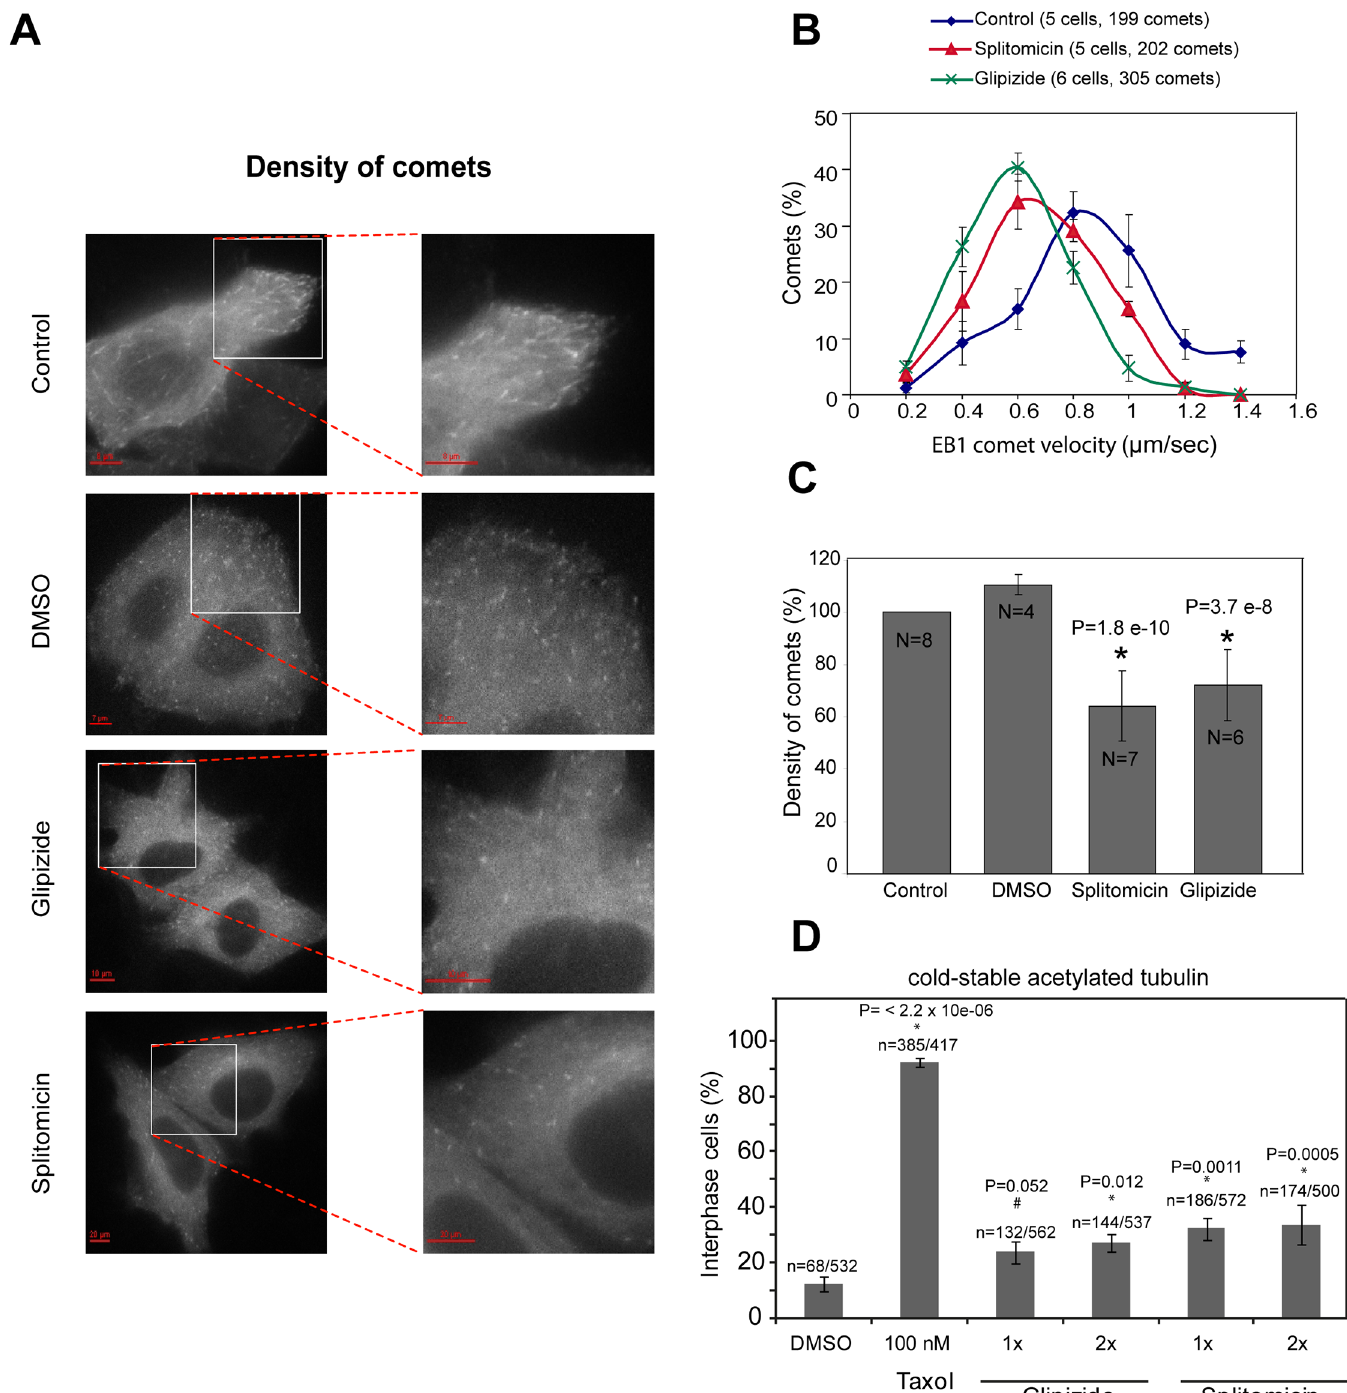
Fig 4. Splitomicin and Glipizide treatment reduce the incidence of microtubule growth and density and increase the amount of acetylated tubulin. (A) Live-cell images of HeLa EB3-TdTomato cells treated with 40 μ M glipizide or 20 μ M splitomicin, as indicated. HeLa EB3-TdTomato expressing cells were treated with the indicated drugs for 1 h and filmed using time-lapse microscopy once every 10 seconds for a period of 5 minutes. Scale bar as indicated. (B) Graph shows drug treatment induced reduction in EB3 comet velocity. Instantaneous velocity of EB3 comets between consecutive time-frames were considered using movies acquired as described in (A). (C) Graph shows drug treatment induced reduction in EB3 comet density. Comet density plotted as percentage of EB3-comets observed per square μ m area in interphase cells. Values are normalised using unperturbed negative control conditions. N = number of cells. (D) Graph showing increased incidence of cold stable and acetylated tubulin bearing microtubules following drug treatments. Cells were treated with two different